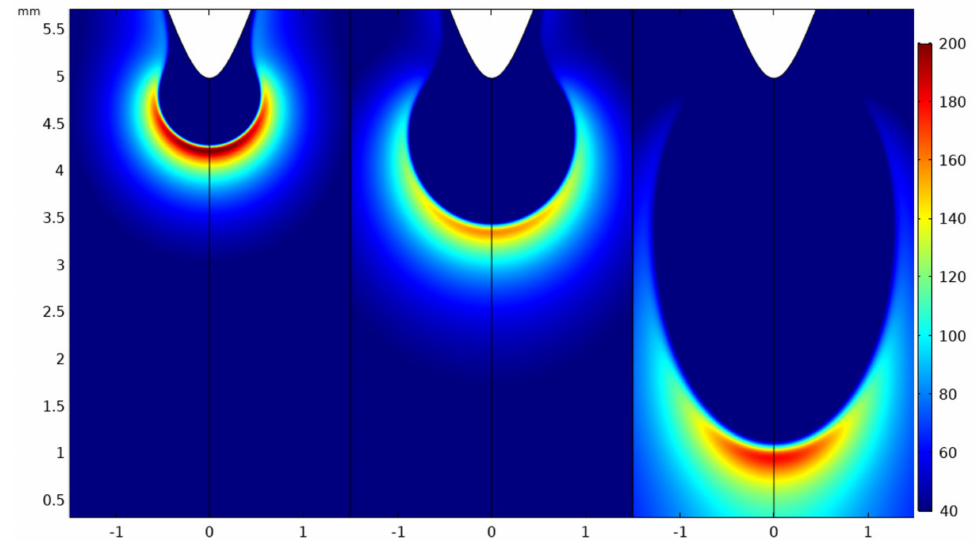
Figure 6. Surface plot of electric field distribution (kV/cm) corresponding to the electron density profile in Figure 5.